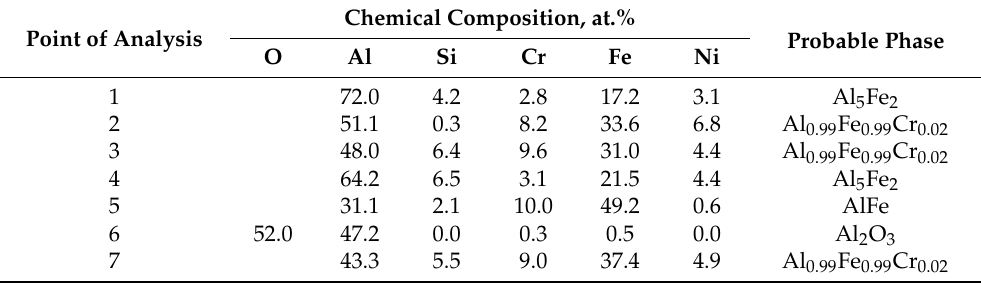
Chemical Composition, at.%